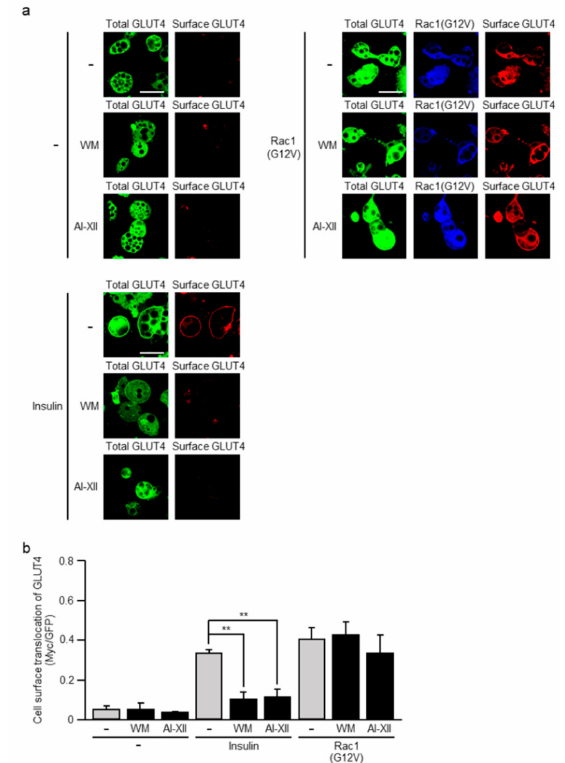
Figure 2. E ff ect of RI-II on GLUT4 translocation induced by insulin or a constitutively activated mutant of phosphoinositide 3-kinase (PI3K) or Akt2. ( a ) L1-GLUT4 adipocytes were infected with the control (-), an N-terminally myristoylated form of the phosphoinositide 3-kinase catalytic subunit p110 α (Myr-p110 α )-expressing, or an N-terminally myristoylated form of Akt2 (Myr-Akt2)-expressing virus. The total amount of GLUT4 myc 7-green fluorescent protein (GFP) was estimated by the fluorescence of GFP. The expression of Myr-p110 α was monitored by immunofluorescent microscopy using an anti-phospho-Akt antibody. Myr-Akt2 was visualized by immunofluorescent microscopy using an anti-hemagglutinin (HA) antibody. Cell surface-localized GLUT4 myc 7-GFP was visualized by immunofluorescent microscopy using an anti-Myc antibody. Scale bar, 50 µ m. ( b ) Cell surface translocation of GLUT4 myc 7-GFP shown in ( a ) was quantified. Data are shown as means ± S.E. ( n = 10). * p < 0.05; ** p < 0.01; *** p <